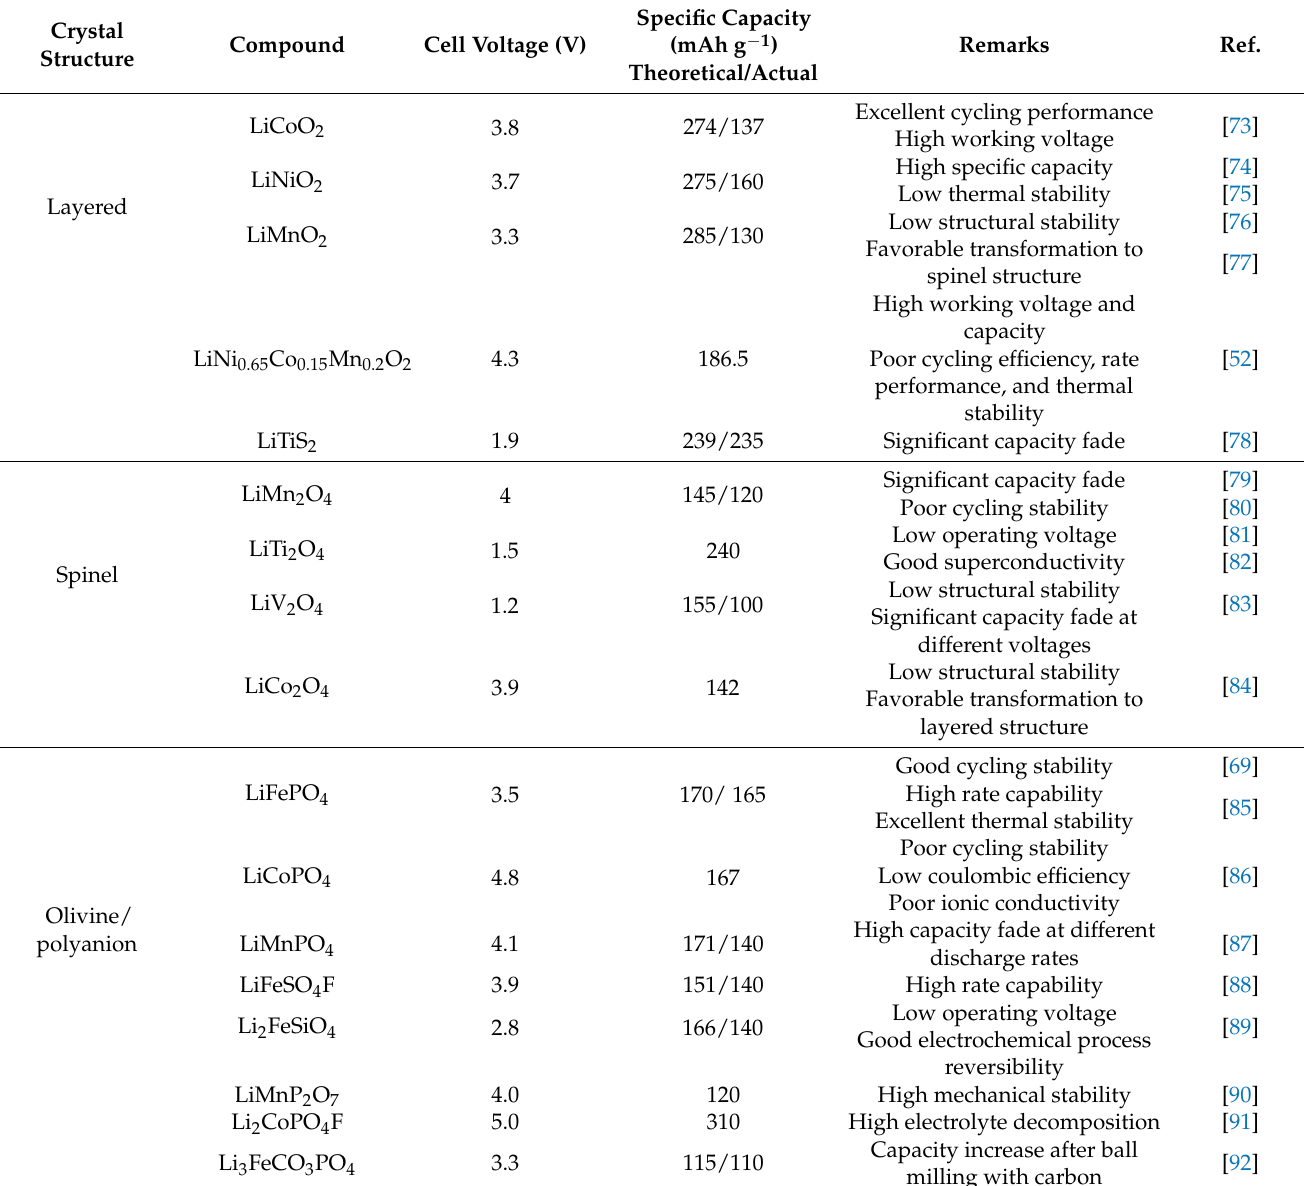
Table 3. Summary of electrochemical performances of different oxide